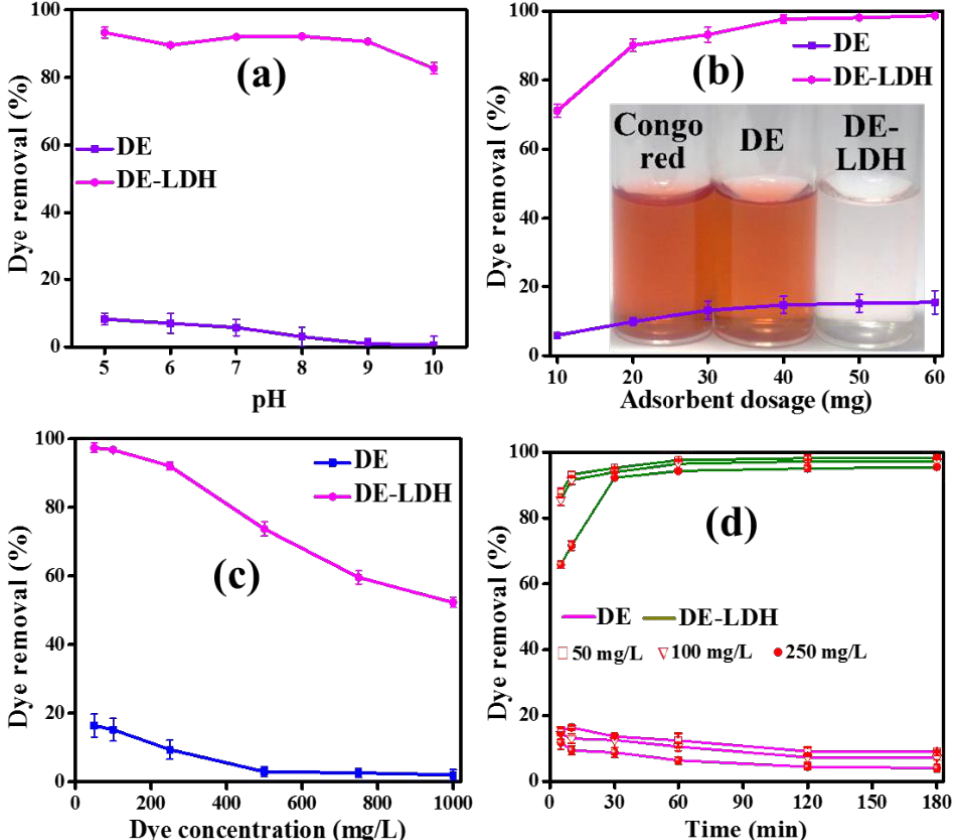
Figure 5. The CR removal e ffi ciency with respect to e ff ect of ( a ) pH, ( b ) adsorbent dosage (inset: photograph of CR supernatant solutions before and after adsorption at pH 7), ( c ) dye concentration and ( d ) contact time.